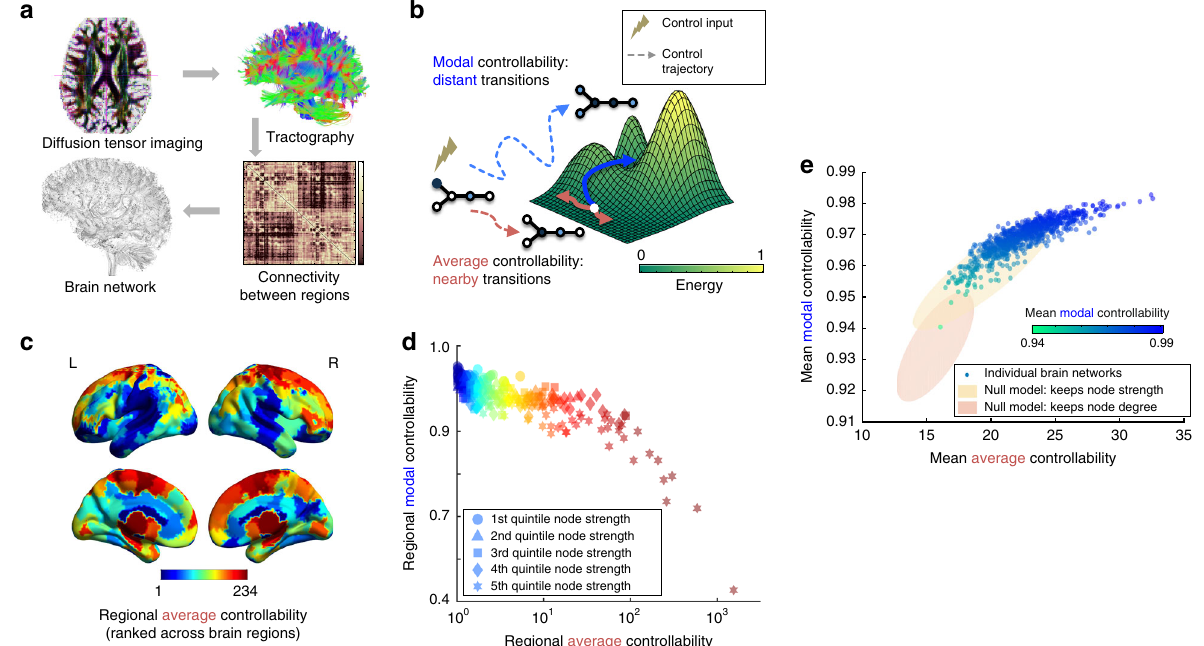
Fig. 1 Controllability in brain networks. a Diffusion tensor imaging measures the direction of water diffusion in the brain. From this data, white matter streamlines can be reconstructed that connect brain regions in a structural network. b Mean average controllability: structural support for moving the brain to easy-to-reach states; mean modal controllability: structural support for moving the brain to dif fi cult-to-reach states. c Regional average controllability ranked on N = 234 brain regions of a group-averaged network for visualization purposes. d Regions with high average controllability tend to display low modal controllability: ρ = − 0.76, df = 233, p < 1 × 10 − 16 ; relative node strength is indicated by shape. e Controllability measures averaged over all regions in the brain networks of 882 healthy young subjects; each colored circle represents a person. People whose brains display high average controllability also tend to display high modal controllability: r = 0.87, df = 881, p < 1 × 10 − 16 . Yellow and red ellipses are the 95% con fi dence clouds of network null models in which the edge weights of the brain networks are shuf fl ed to preserve strength or degree,